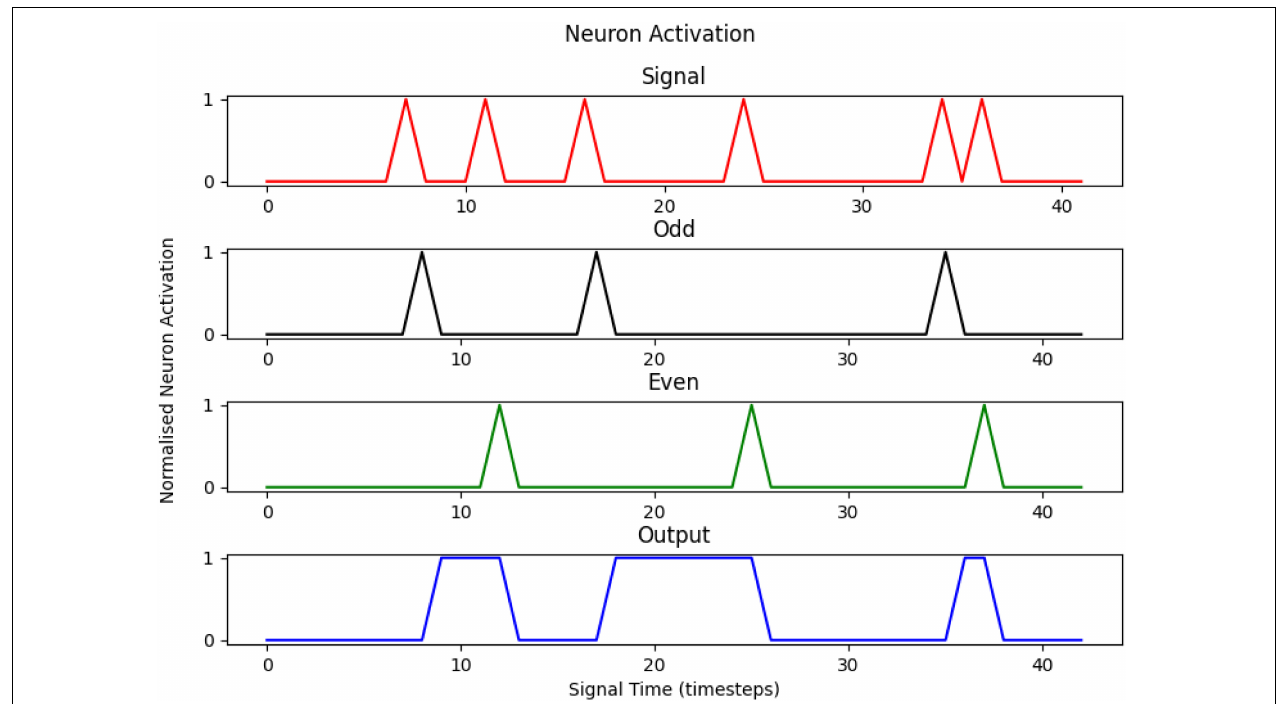
FIGURE 3 | The activation profiles of the neurons in the artificial neural network, for a sample signal of 6 pulses. The output is 1 for an odd signal and 0 for an even